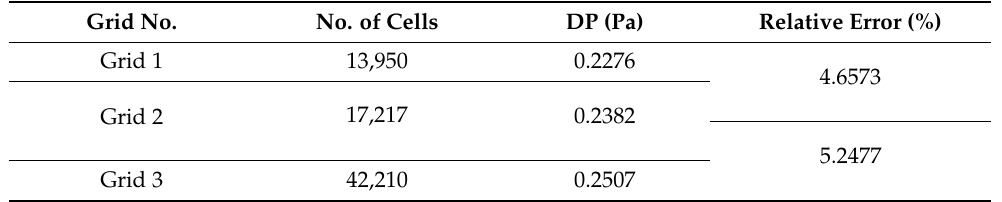
Table 3. Mesh independence. Grid